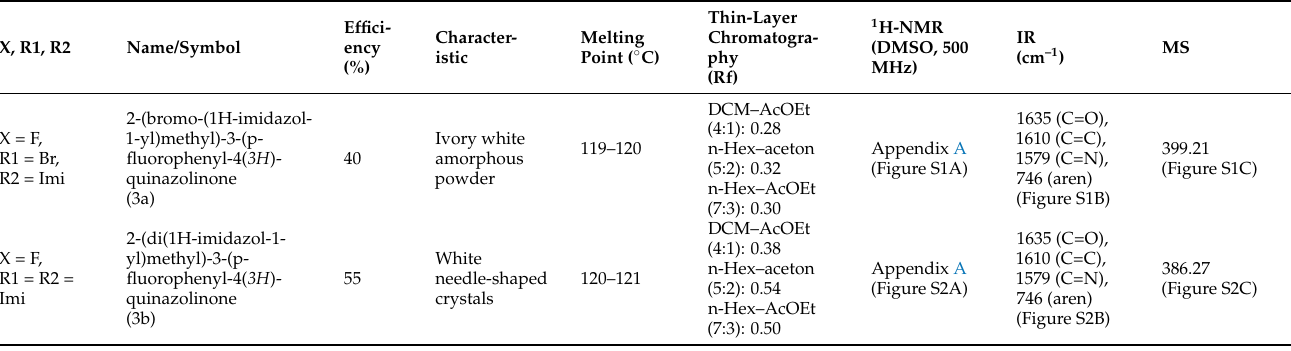
Figure 3. 2-disubstitutedmethyl-3-p-substitutedphenyl-4( 3H )-quinazolinone derivatives ( 3a–s ). Table 3. Properties of the synthesized 2-disubstitutedmethyl-3- p -substitutedphenyl-4( 3H )-quinazolinone derivatives ( 3a–s ).